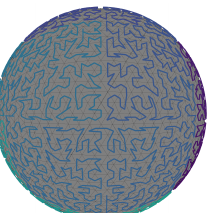
Figure 10. Space filling curve (SFC) of a level 4 icosahedron generated using the S2 Geometry Library. Each cell’s surface normal is mapped to an integer creating a linear ordering for a curve. The curve is colored according to this mapping and traverses each